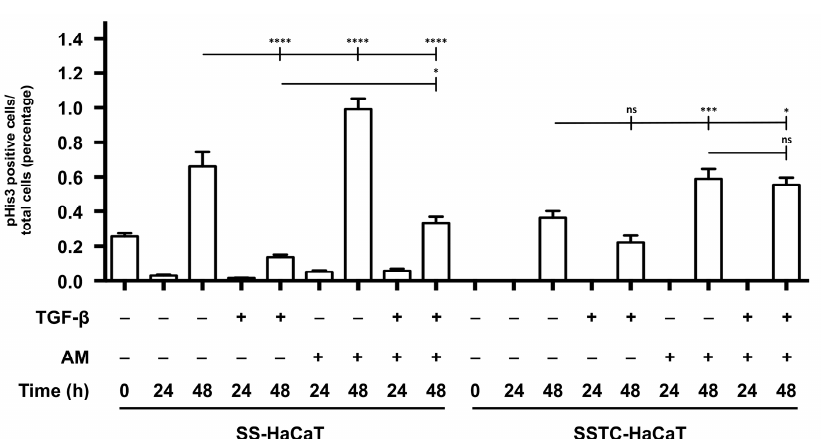
Figure 5. Amniotic membrane promotes cell division at the wound edge of HaCaT-cells persistently exposed to TGF- β . Quantification of the proliferation of wounded in vitro monolayers evidenced through immune labeling. Reference pictures were taken for the indicated times for each condition and treatment. Replicates from three independent experiments were analyzed. Shown data represent the mean ± SEM. Asterisks denote statistically significant differences (* p < 0.05, *** p < 0.0005, **** p < 0.00005); ns, non-signi fi cant.